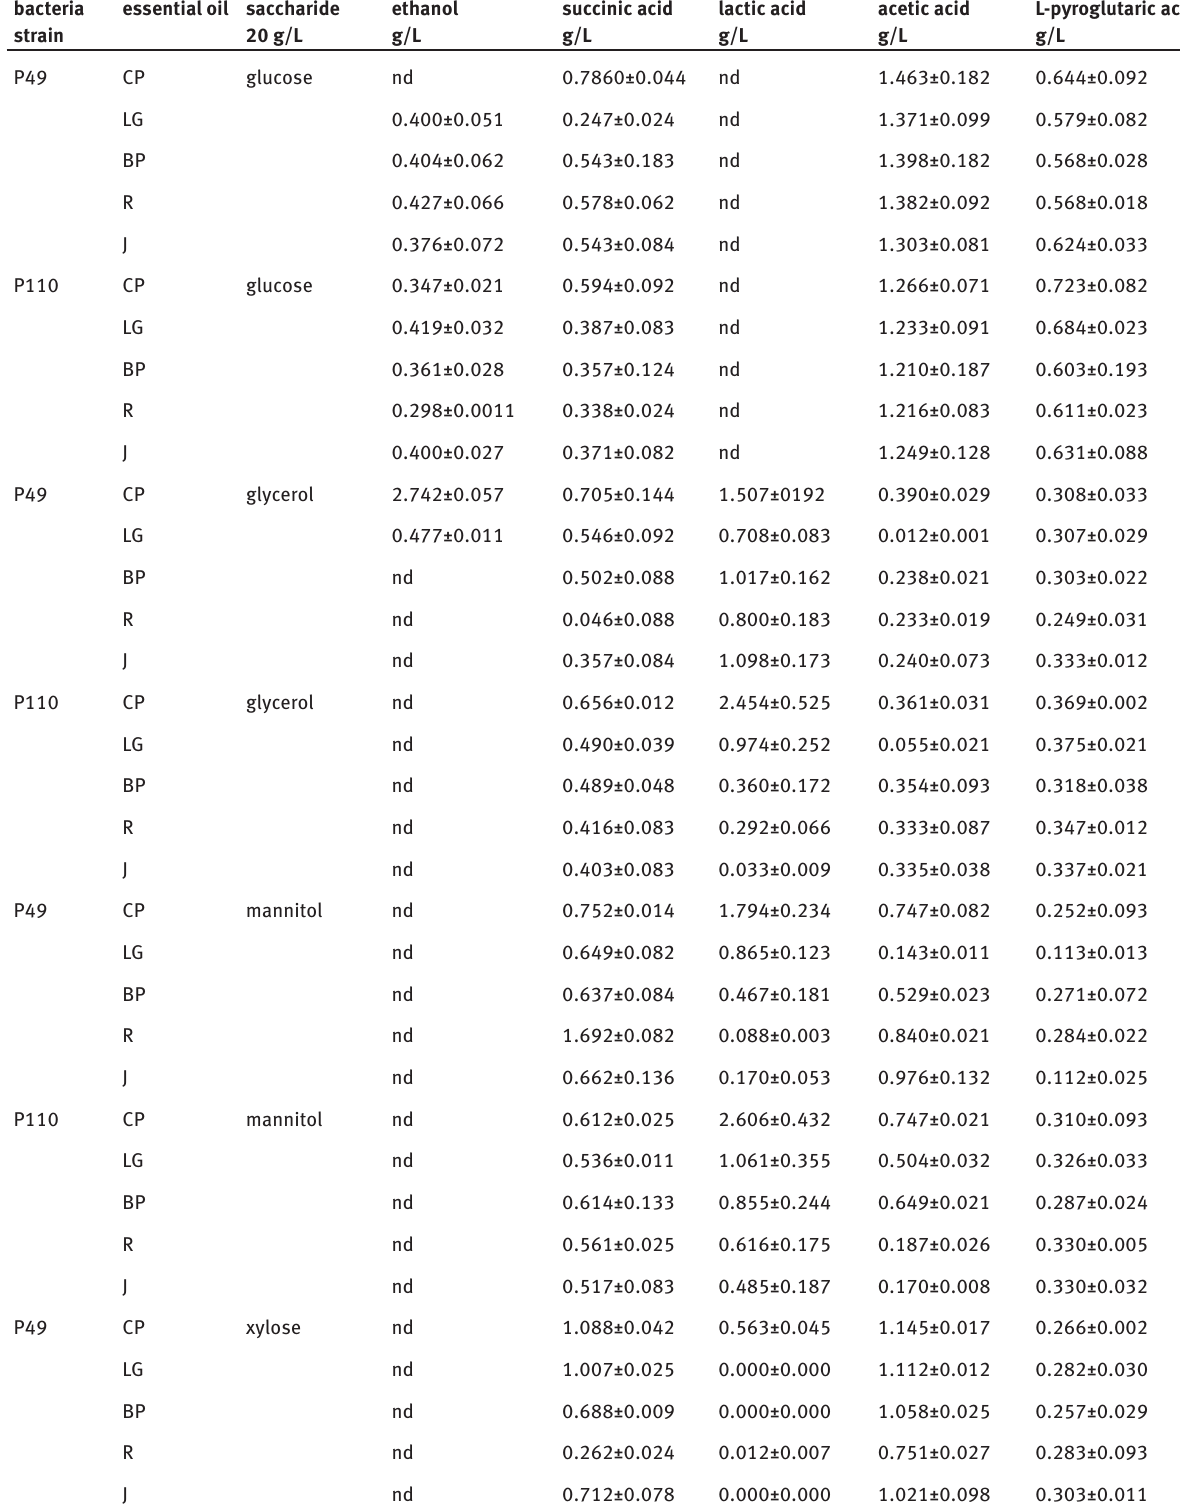
Table 5: The ability of utilization/conversion of selected saccharides by P. orientalis strains in normal cultivation and under the influence of investigated EOs in sub-inhibition